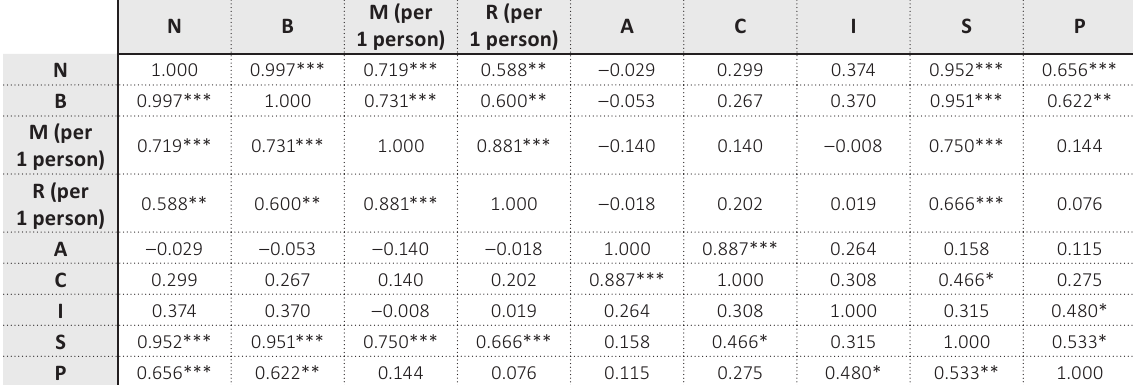
Table 1. Matrix of paired correlation coefficients between indicators that comprehensively characterize the residential real estate market of Ukraine in 2015